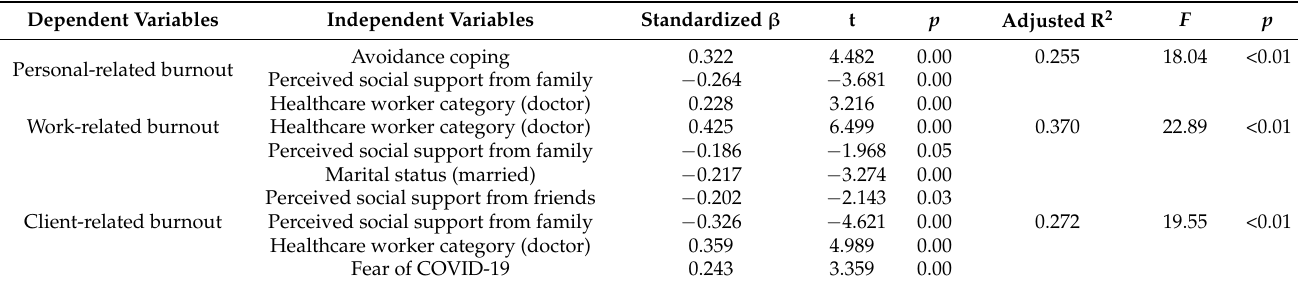
Table 4. Factors affecting the burnout among healthcare workers